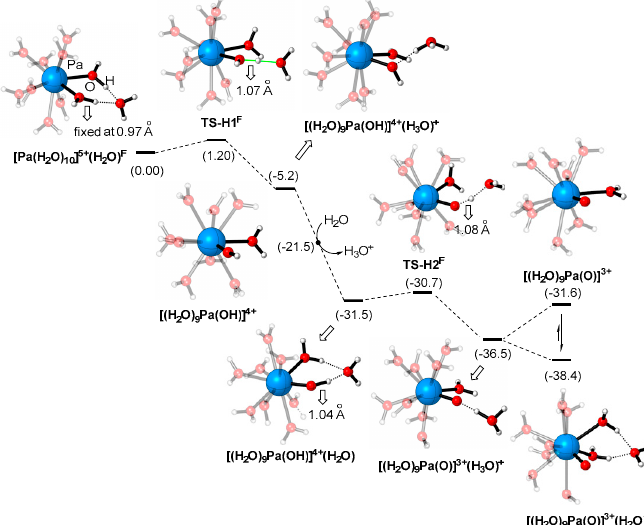
Figure 5. The Gibbs free energy profile for formation of [Pa(H 2 O) 10 ] 5+ (H 2 O) to [PaO(H 2 O) 9 ] 3+ (H 2 O) calculated with B3LYP-D3(BJ)/GEN/IEF-PCM//B3LYP/GEN /IEF-PCM method (for details